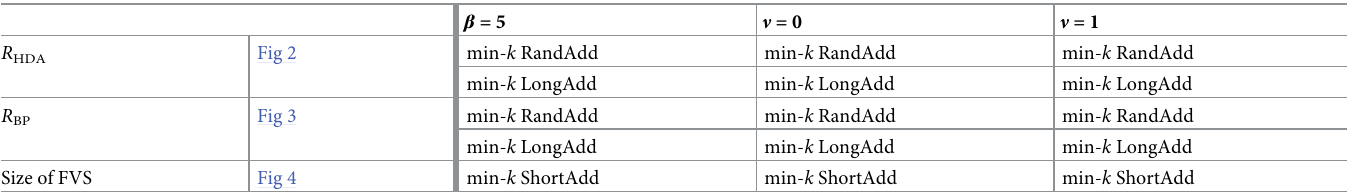
Table 3. The most effective methods for improving R HDA , R BP , and the size of FVS to random